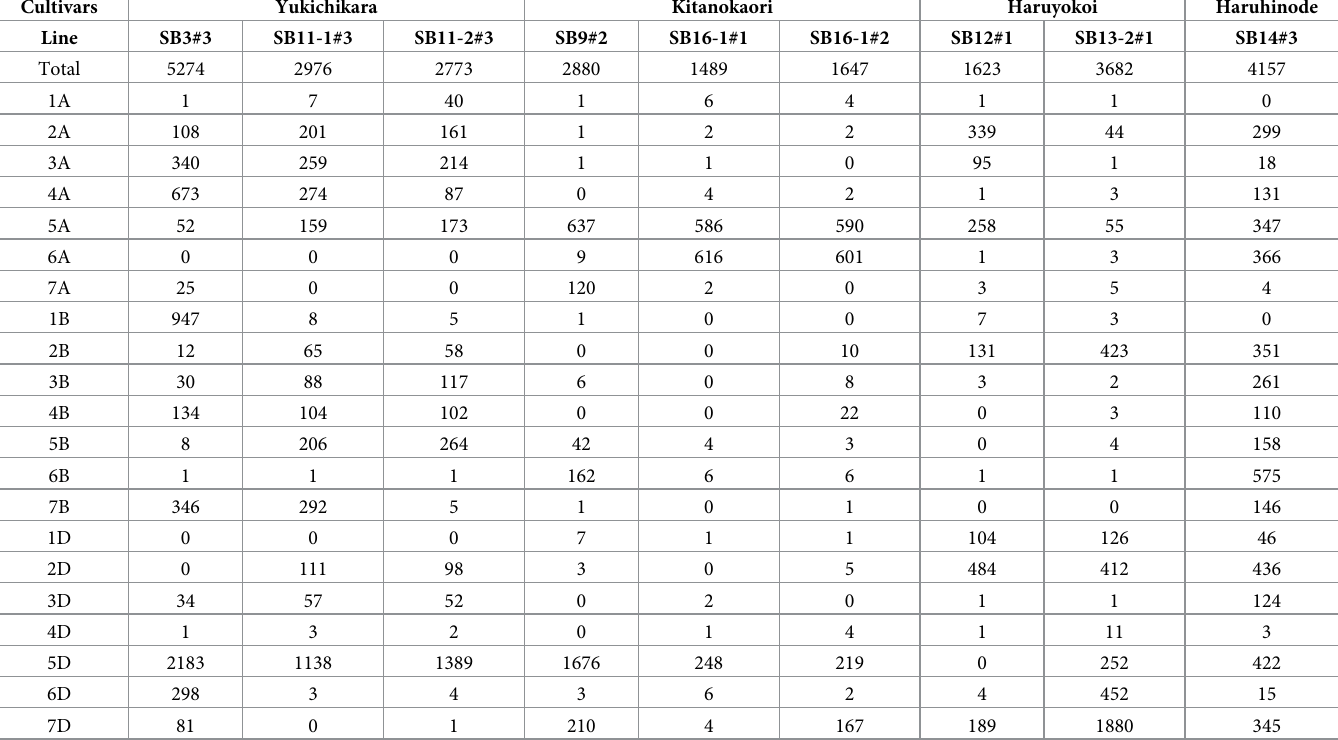
Table 7. SNPs between early heading lines and their backcrossed wheat cultivars.